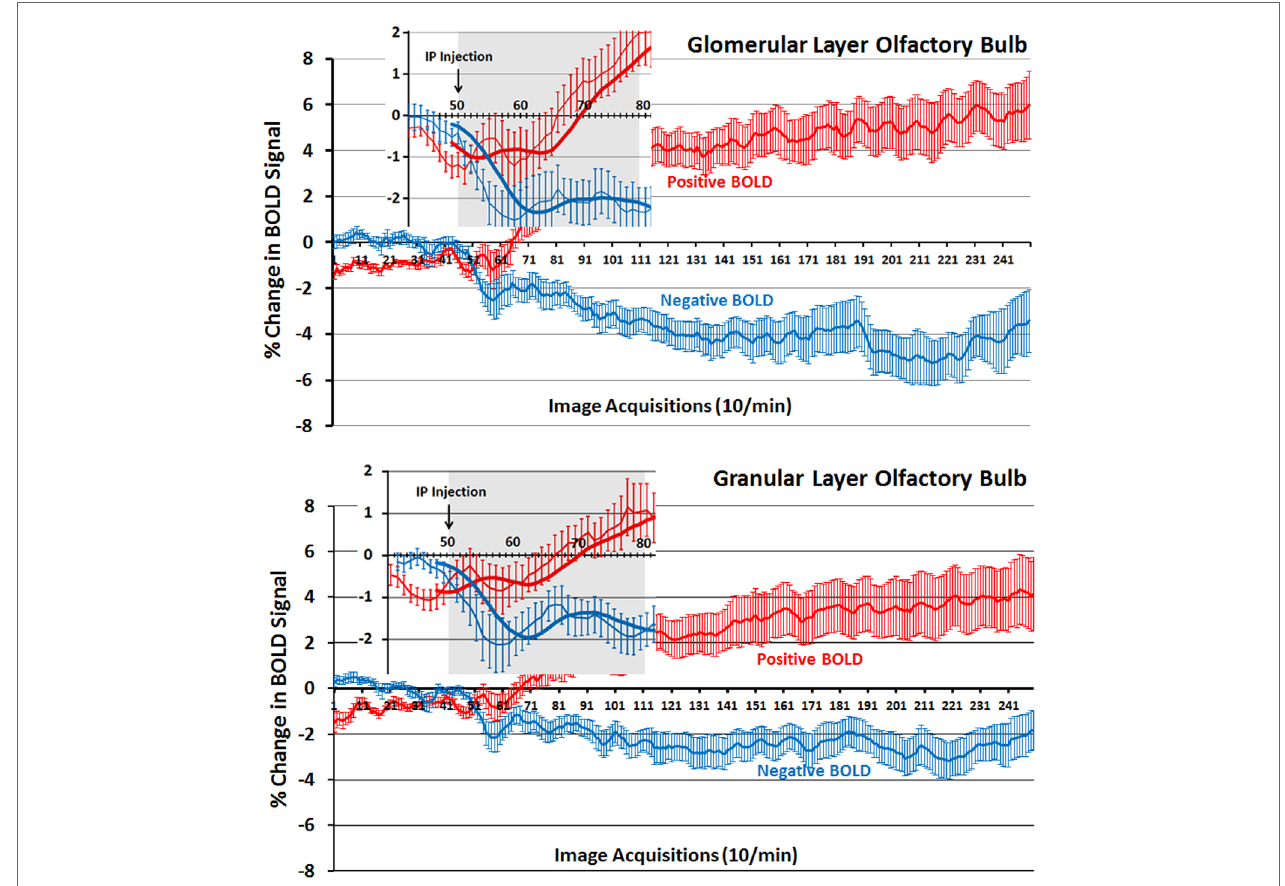
FigUre 6 | Time-course plots for positive and negative BOlD in the olfactory bulb . Shown are the changes in positive (red) and negative (blue) BOLD signals over time in the glomerular and granular layers of the olfactory bulb following intraperitoneal injection of OT. The insert is a magnified cut-out of the 3 min following injection. The thick lines show trend lines as an average of eight acquisitions. Vertical bars denote